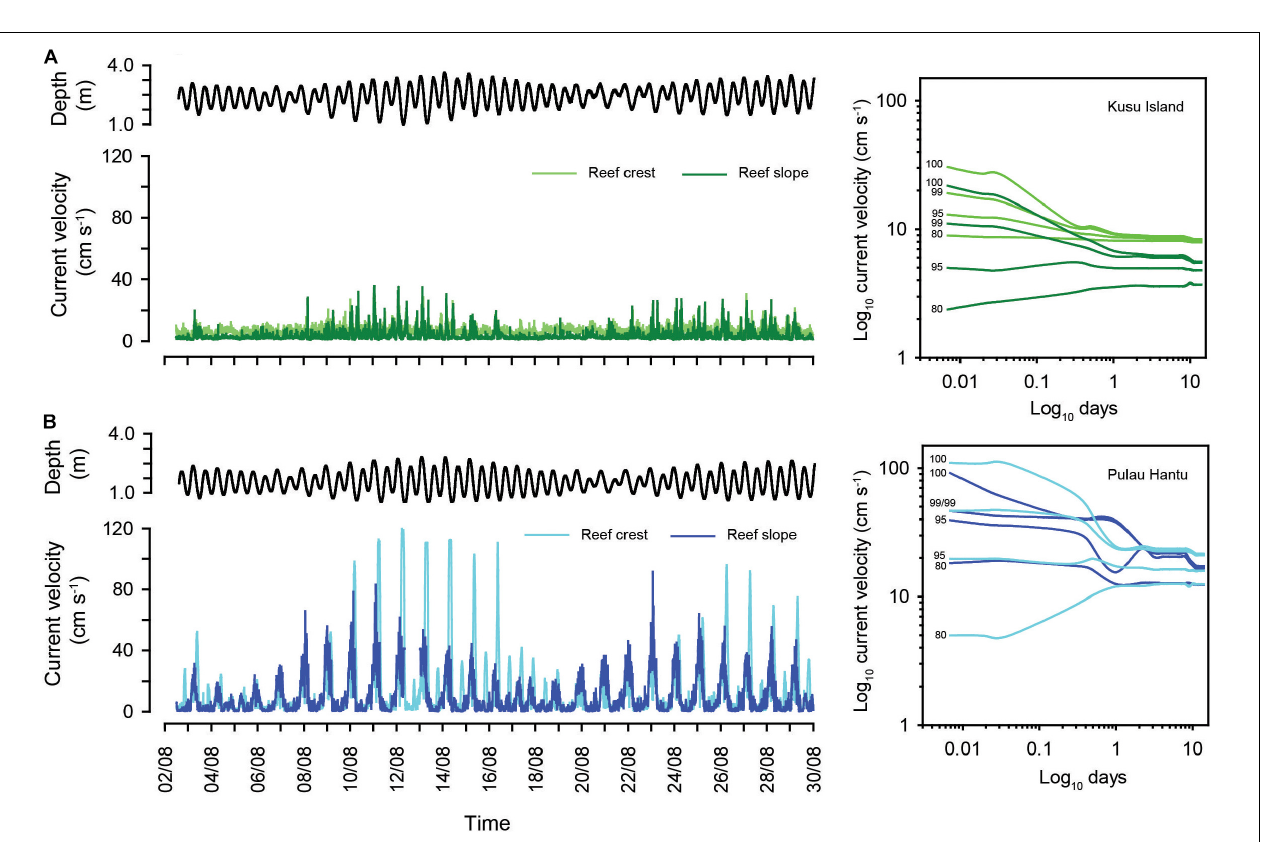
FIGURE 5 | Time series of current velocities (cm s − 1 ) for reef crest and reef slope sites at (A) Kusu Island (green) and (B) Pulau Hantu (blue). Water depth (m) across the 30-day deployment is shown for each site (black). Panels on the right show percentile plots of the running means percentile analysis for each depth zone. The 100th (maximum), 99th and 95th and 80th percentiles of the running means are displayed.